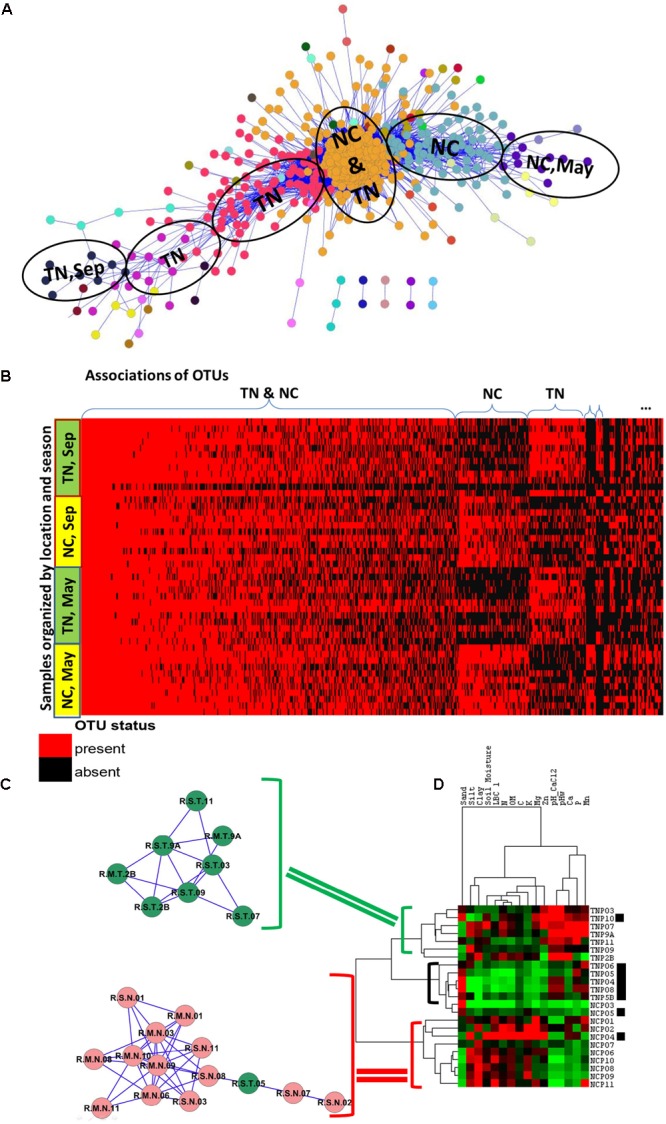
Associations of rare species and samples in PRM study. (A) Communities of associated fungal and bacterial OTUs discovered by the Anets-OTUs algorithm in rhizoshpere of Populus deltoides. Nodes in the network indicate OTUs and edges indicate pair-wise association between them. The node color shows the community (cluster) assignment inferred by clustering. (B) Presence–absence map of the associated OTUs; the cell color is red if OTU is present in the sample and it is black if OTU is absent. OTUs are grouped according to the microbial communities inferred by Anets-OTUs and sorted by mean abundance; samples are grouped according to clusters inferred by Anets-Samples and sorted by the shared richness. (C) Two associations of Populus rhizoshpere samples with the shared species richness revealed by Anets-Samples; color indicates samples taken in NC (red) and in TN (green). (D) Hierarchical clustering of the soil properties; brackets indicate three cluster of soil samples with distinct soil properties: green bracket indicates the cluster of soil samples that correspond to the association of rhizosphere samples in TN, red bracket indicates the cluster of soil samples that correspond to the association of rhizosphere samples in NC, black bracket and black squares indicate samples that don’t found as associated by Anets-Samples.